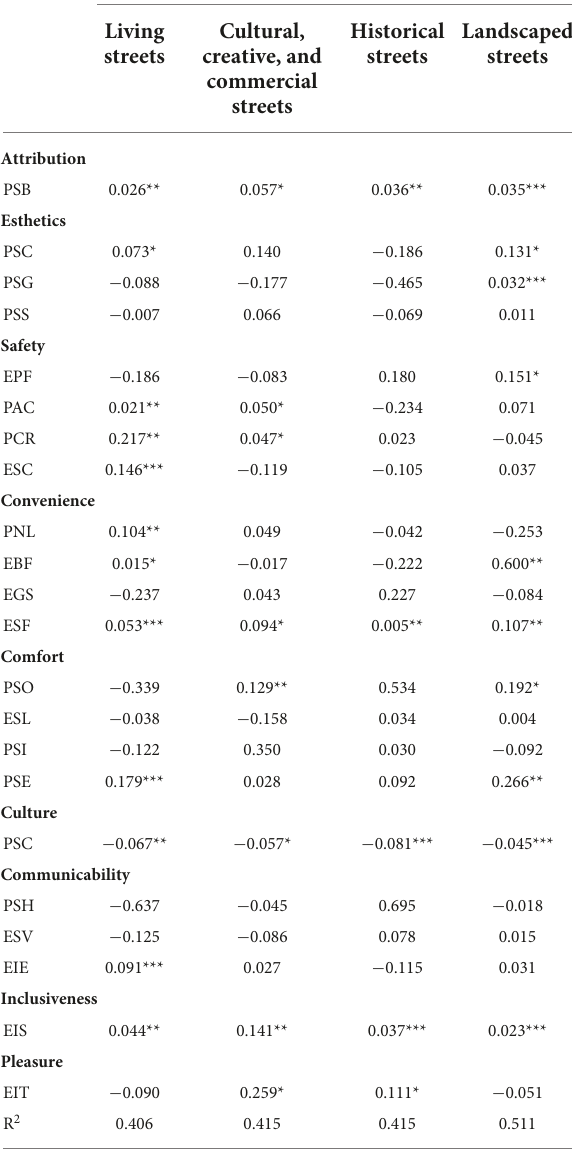
TABLE 4 Ordinary Least Squares (OLS)